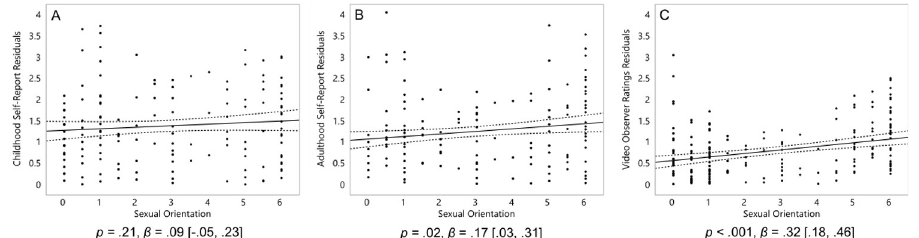
Fig 3. Masculinity of 196 women. Absolute residuals derived from the effects displayed in Fig 1 for masculinity of 196 women (self-report from childhood, A; and adulthood, B) and 191 women (observer-ratings, C). On the Y axis, residuals for masculinity, with higher scores representing a greater degree of variance from the main effect. On the X axis, 0 represents exclusive heterosexuality, 3 represents bisexuality, and 6 represents exclusive homosexuality. Triple lines represent regression coefficients with their 95% confidence intervals. Dots represent participants’ residuals. Statistics represent linear effects.